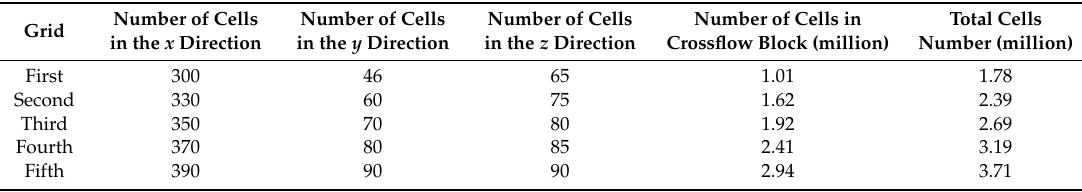
Table 3. Specifications of mesh arrangements in the grid sensitivity test of the triple-hole system.